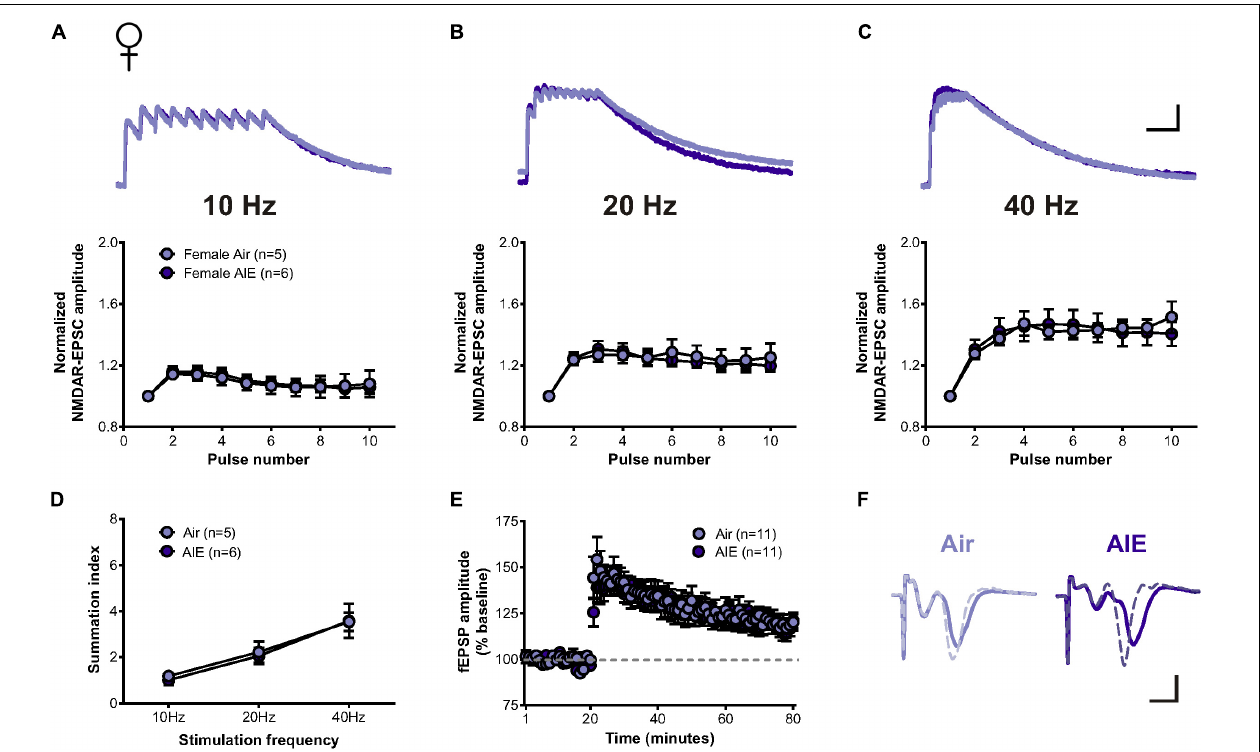
FIGURE 4 | Temporal summation of NMDAR-EPSCs and LTP following acute withdrawal from AIE in the female dlBNST. (A–C) Representative traces (top; Air light purple, AIE dark purple) and pooled data (bottom) demonstrating the lack of difference between female groups in response to 10 stimulation pulses given at 10, 20, and 40 Hz to induce temporal summation of NMDAR-EPSCs; vertical scale bar = 200 pA, horizontal scale bar = 200 ms. (D) Plot of the summation index across stimulation frequencies and treatments demonstrating no significant difference in temporal summation following AIE in females. (E) Time course showing no difference in synaptic field potentials at baseline (20 min) and after the induction of LTP by high-frequency stimulation (two 1-s trains at 100 Hz) in the dlBNST of mice from Air- and AIE groups. (F) Representative traces recorded from Air (light purple) and AIE (dark purple) female mice before (solid) and 60 min after (dashed) the high frequency tetanus; vertical scale bar = 0.3 mV, horizontal scale bar = 2 ms. All data points represent the mean ±